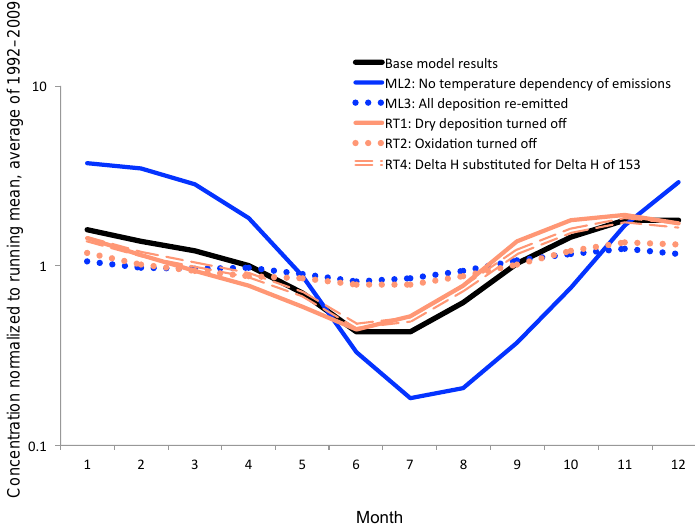
Figure 5. Changes in mean surface Arctic PCB 28 seasonal variation with sensitivity simulations, averaged over time (1992–2009). Simulated concentrations have been normalized to a running mean. Sensitivity simulations that flatten the simulated seasonal cycle are those that minimize the model–measurement gap in the